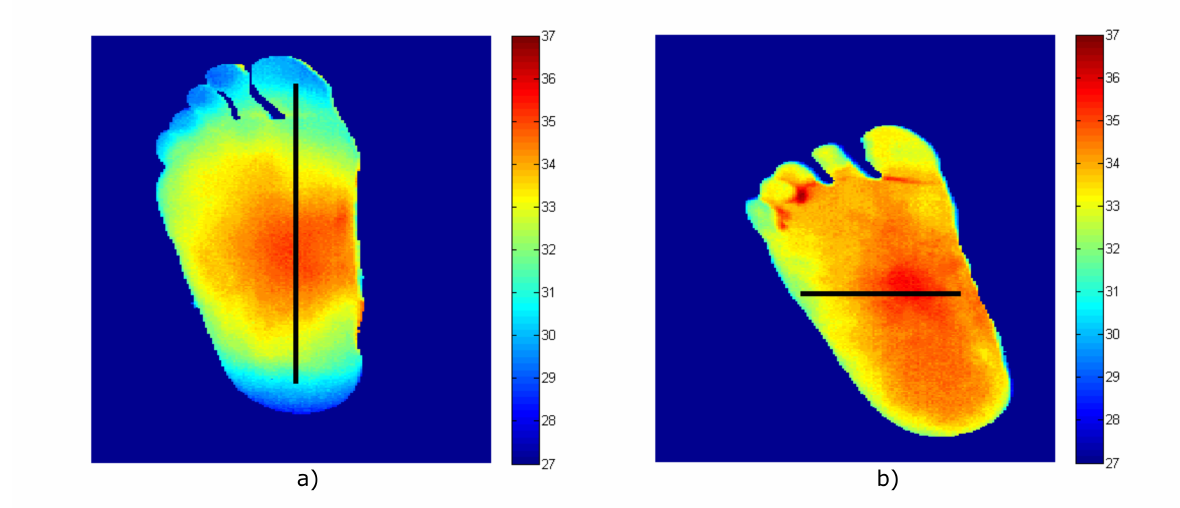
Figure 10. The temperature patterns of the right foot acquired employing the infrared camera (temperature values in degrees Celsius, equivalent to T ( ◦ C) = T (K) − 273.15). ( a ) Volunteer # 1 . ( b ) Volunteer # 2